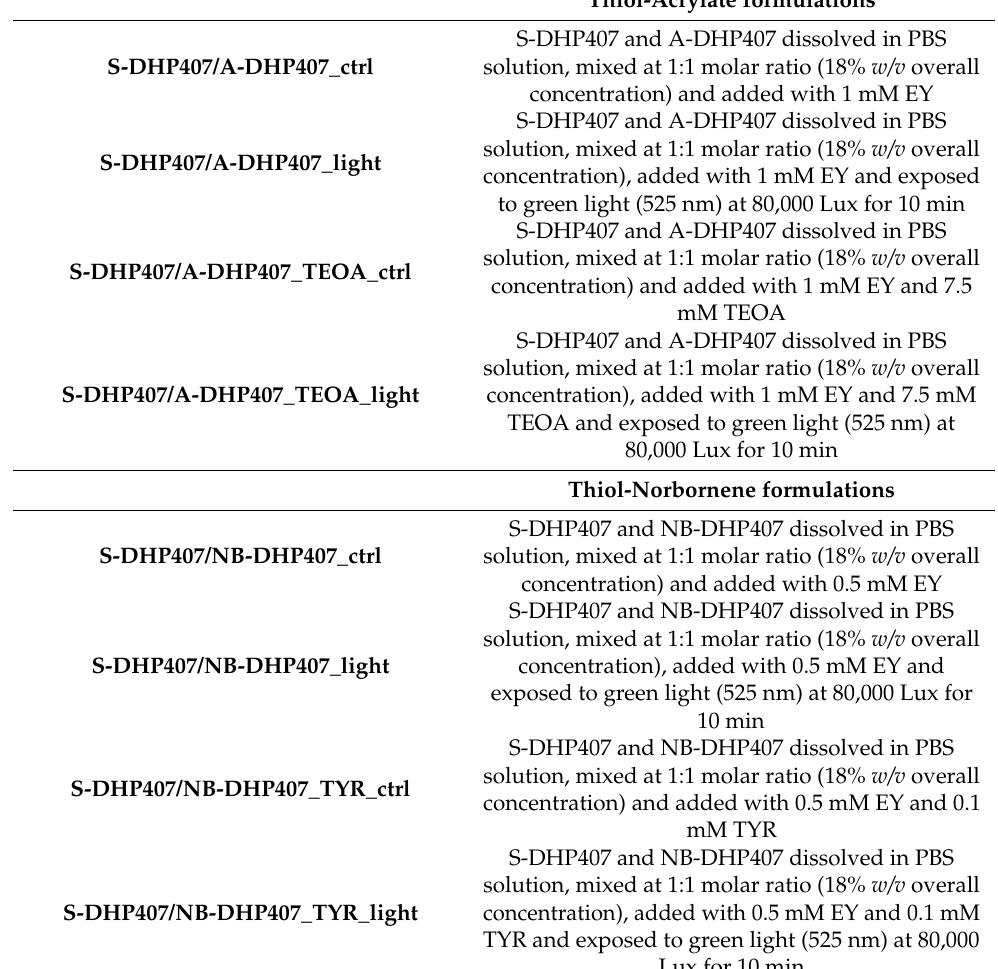
Table 1. Acronyms adopted to refer to rheologically characterized thiol-ene PEU-based formulations and their corresponding